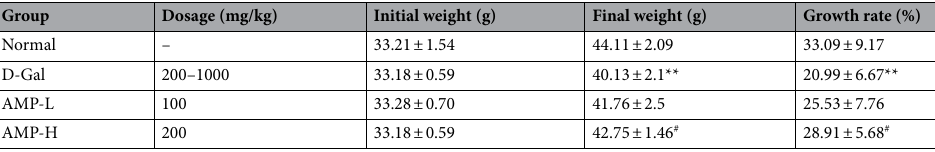
Table 1. Effect of AMP on the body weight of aging model mice. Values represent the mean ± S.D., n = 10. *p < 0.05 or **p < 0.01 vs. normal group; # p < 0.05 or ## p < 0.01 vs. D-Gal group. The table was drawn using